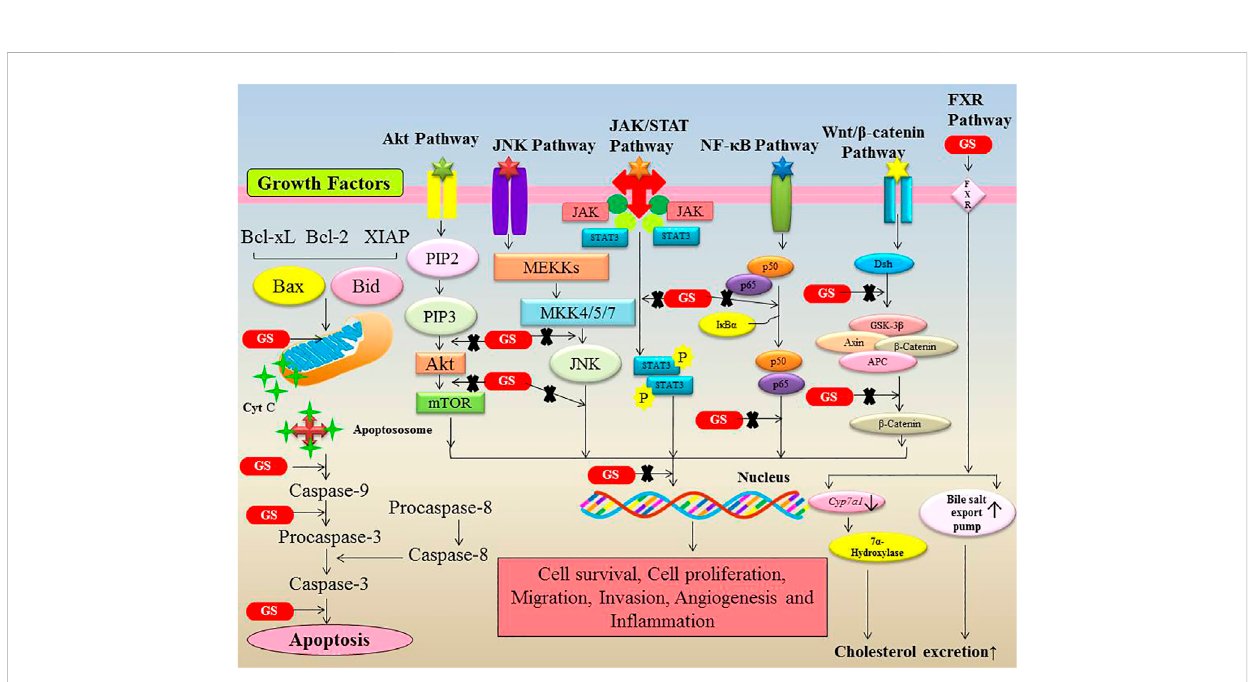
FIGURE 2 Modulation of various signalling pathways involved in cancer by Guggulsterone. Guggulsterone modulates the expression of numerous proteins involved in cell survival, cell proliferation, migration, invasion, angiogenesis and in fl ammation.